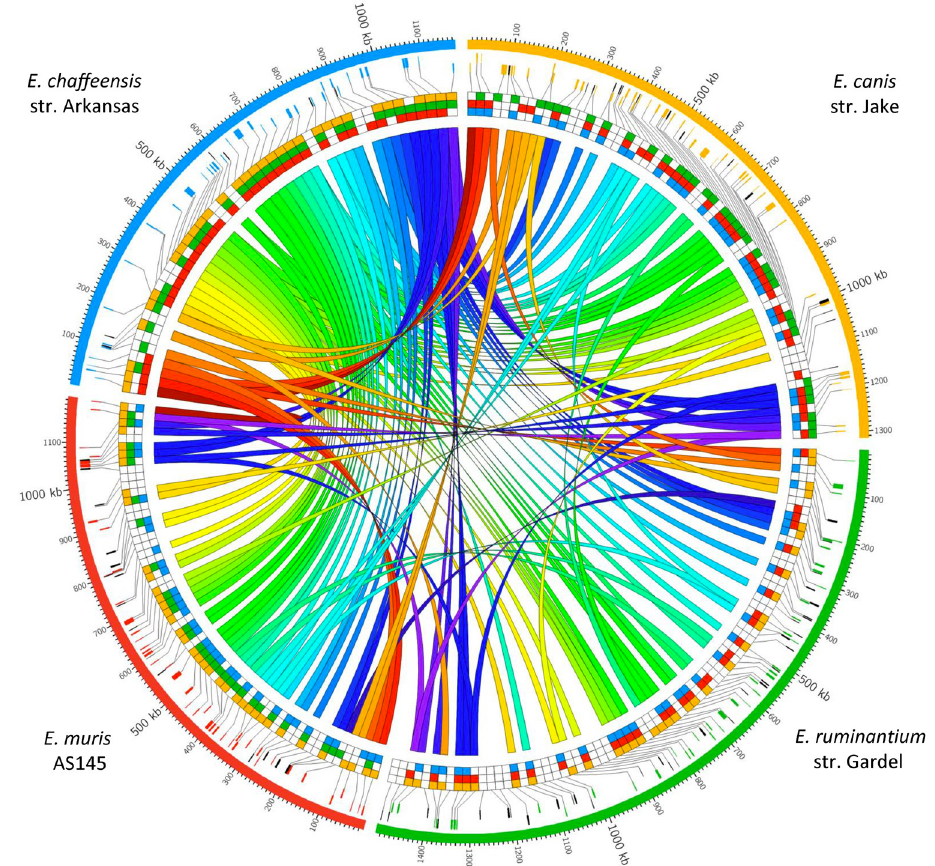
Fig 4. Mapping of Ehrlichia spp . predicted Type IV effectors (pT4Es) and their homologies highlights the genomic plasticity of this genus. Genomes of E . chaffeensis str. Arkansas (blue), E . canis str. Jake (orange), E . ruminantium str. Gardel (green) and E . muris AS145 (red) are represented in the outer circle of this Circos graph. The second and third circles represent the genes encoding the pT4Es (sense and antisense genes, respectively). The genes are colour coded depending on the genome in which they originated and species-specific genes are in black. Links using a spectral color scheme show homologies between pT4Es of the four genomes. The homologies between the pT4Es of the four genomes are also represented by squares of the corresponding genome